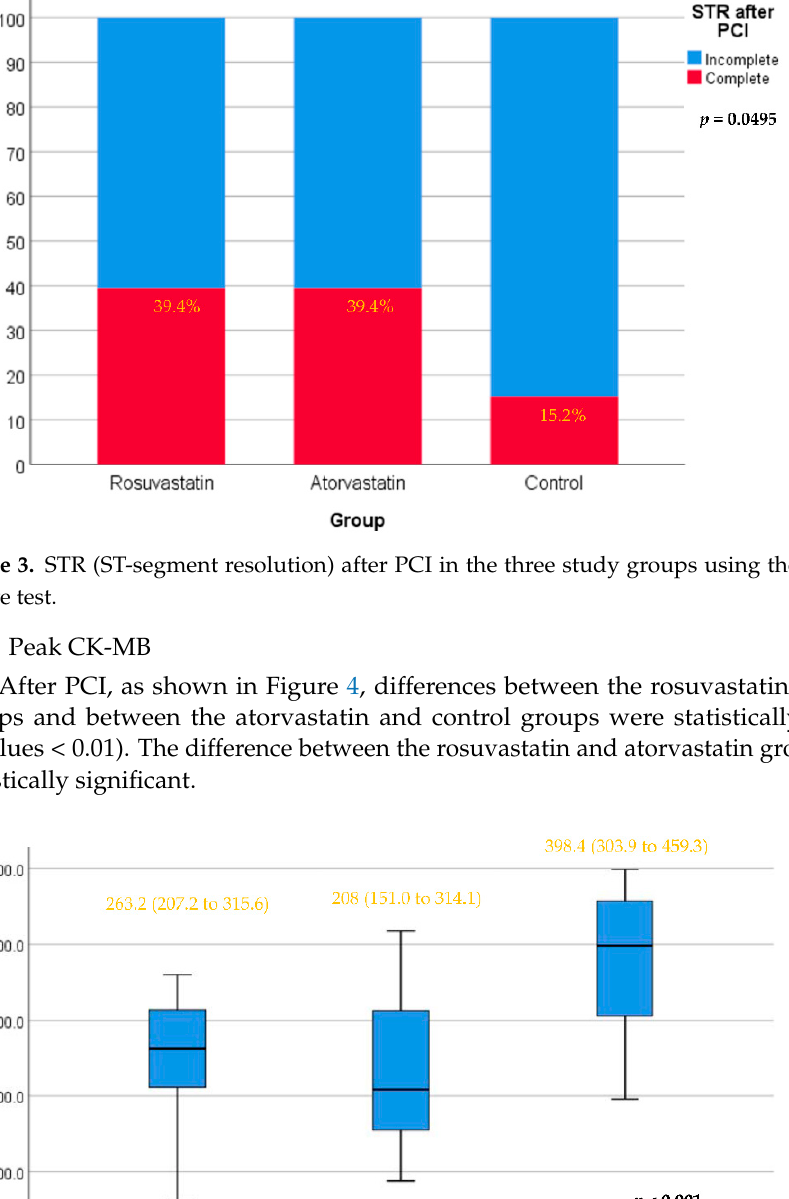
Figure 4. Peak CK-MB level in the three study groups. Box represents the interquartile range. Line inside the box represents the median. Error bars represent minimum and maximum values. Differ- ences between the rosuvastatin and control groups and between the atorvastatin and control groups were statistically significant ( p -values < 0.01). The difference between the rosuvastatin and atorvas- tatin groups was not statistically significant. The test applied was the Kruskal–Wallis test. Table 3. Multivariable linear regression analysis for effect of rosuvastatin or atorvastatin on the LVEF at hospital discharge as adjusted for onset to presentation time.